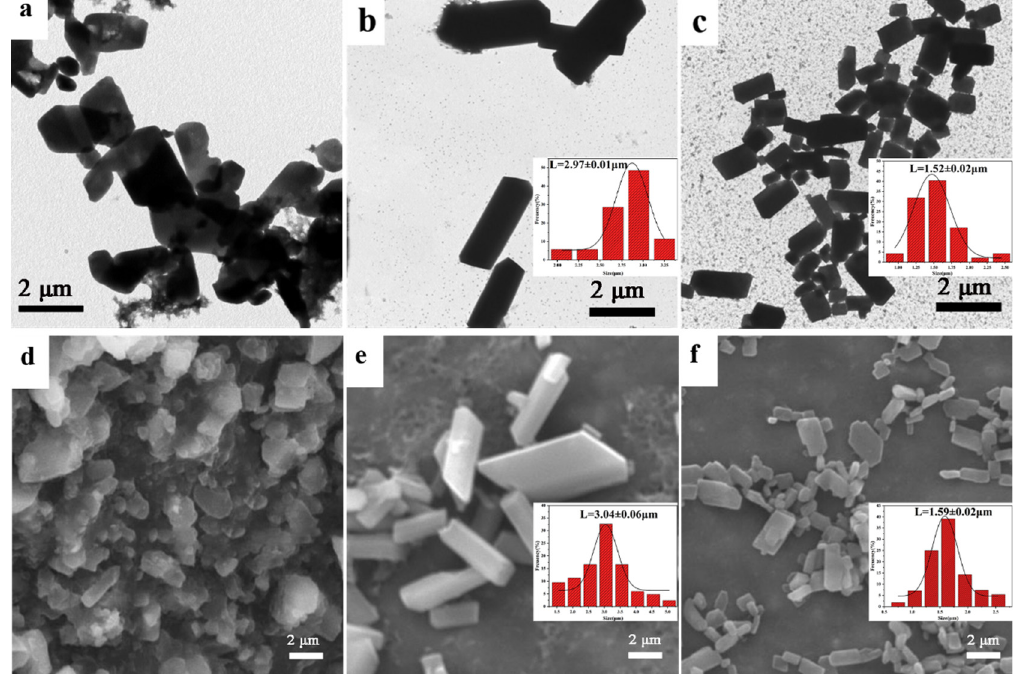
Figure 1. Characterization of complex structure. TEM images: ( a ) ETPC, ( b ) ETPC-SA, and ( c ) ETPC-HQ; SEM images: ( d ) ETPC, ( e ) ETPC-SA, and ( f ) ETPC-HQ.